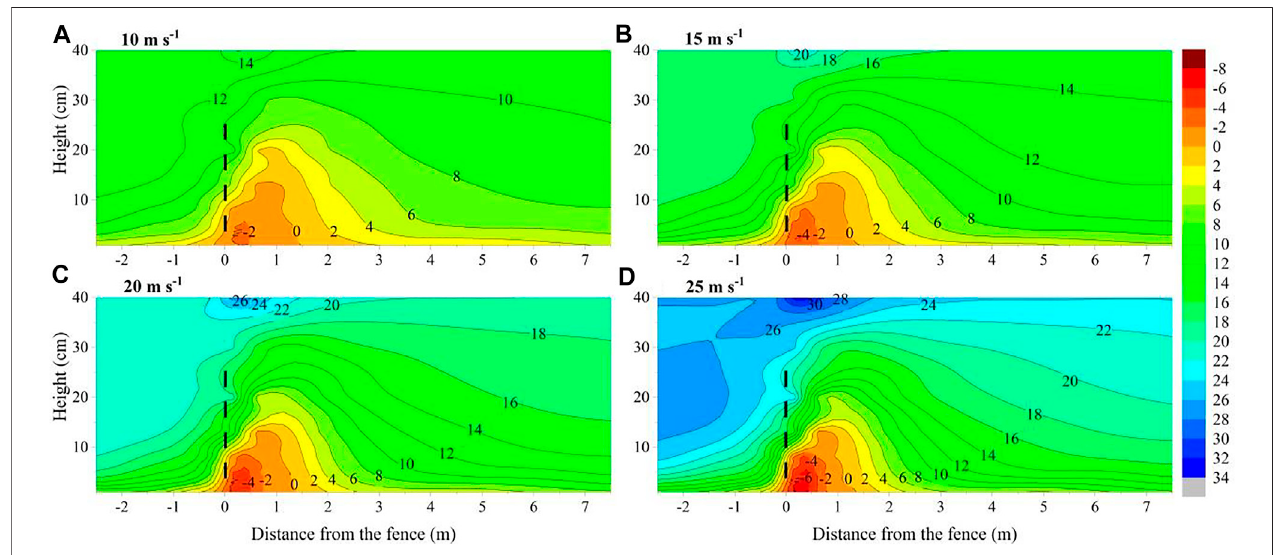
FIGURE 5 | Velocity contours (m s − 1 ) in the vicinity of the single-row straight-installed plate (SIP) under different free-stream wind velocities. The negative wind velocities represent recirculated air fl ow, and the dashed line shows the position of sand fences.